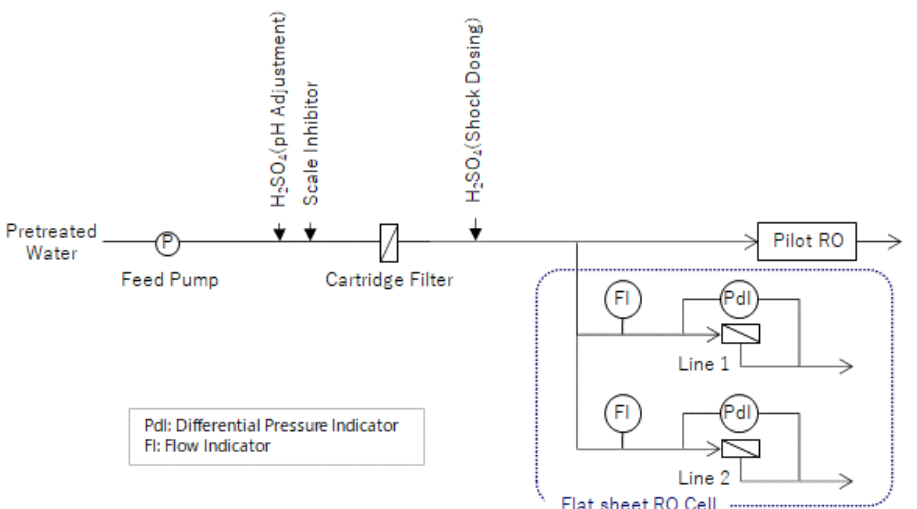
Figure 4. Appearance of the flat sheet membrane cell.